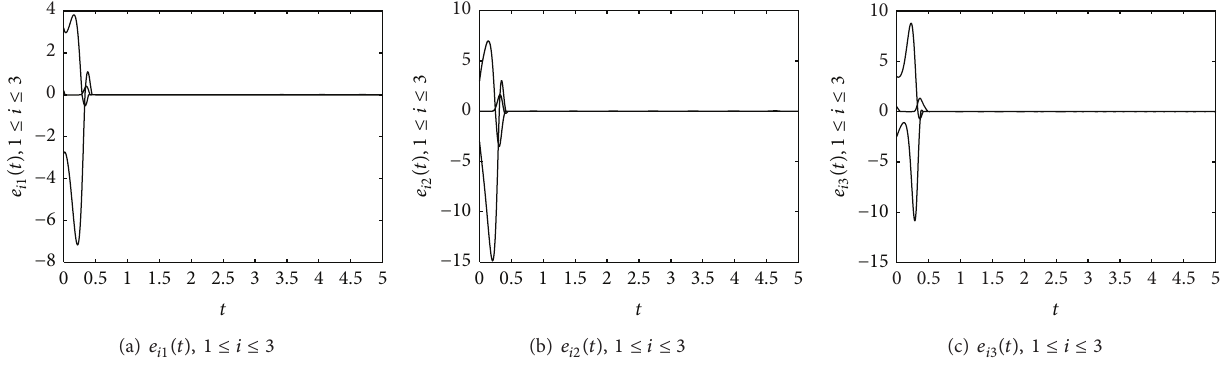
Figure 3: Synchronization errors between (30) and (28) with adaptive controllers